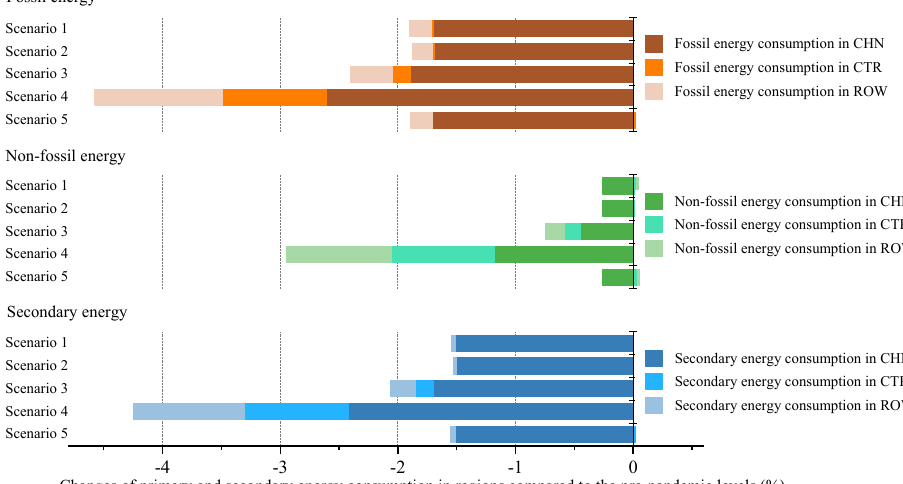
Figure 5. The impact of the COVID-19 outbreak in China on primary and secondary energy consumption in trade regions in the context of trade protectionism.